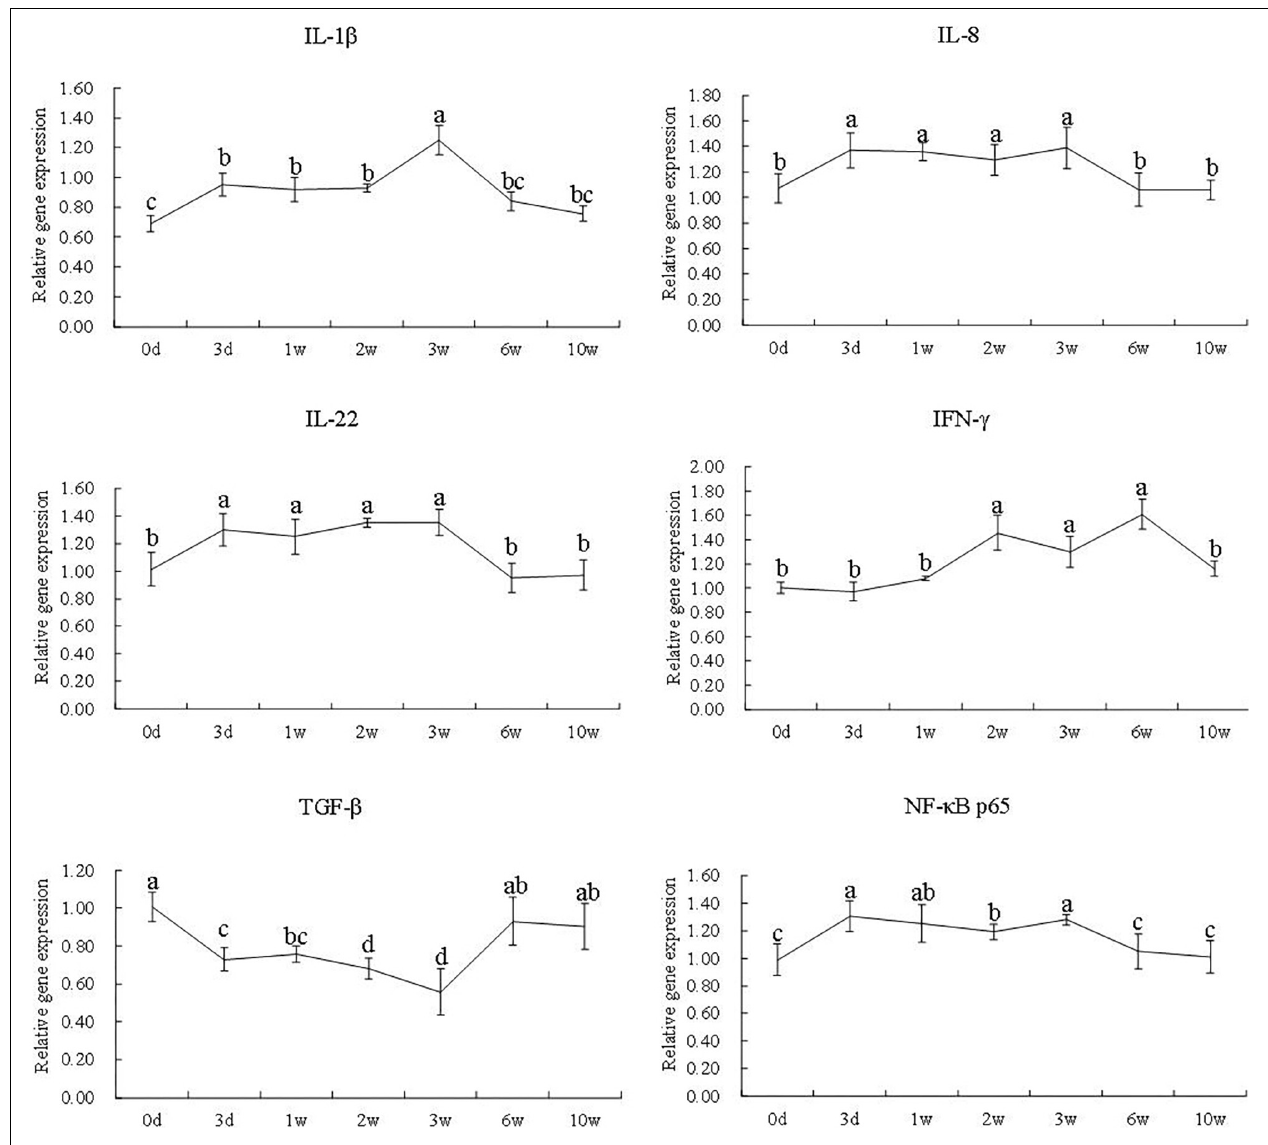
FIGURE 4 | The gene expression of IL-1 β , IL-8, IL-22, IFN- γ , TGF- β , and NF- κ B p65 at different time points in the 7S&FM group. Results are expressed as means ± standard error. Different letters above the broken lines denote significant ( P < 0.05) differences at different time